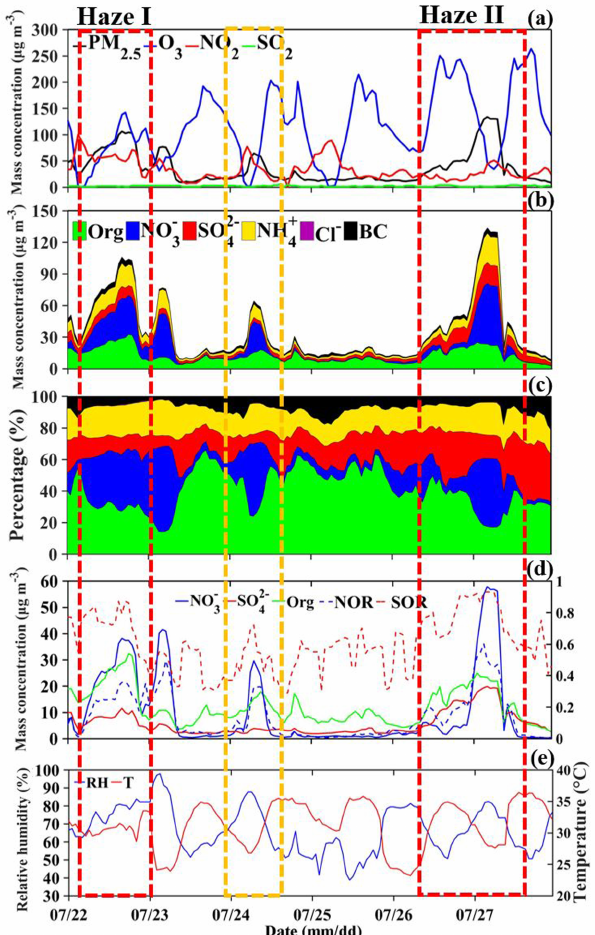
Figure 6. Temporal variation in the (a) PM 2 . 5 , O 3 , NO 2 and SO 2 mass concentrations; (b) PM 2 . 5 chemical composition, including organics (Org), sulfate (SO 2 − ), nitrate (NO − ), ammonium salt 4 3 (NH + ), chlorine salt (Cl − ) and black carbon (BC) at the BJ site 4 from 22 to 27 July 2019. (c) Temporal variation in the relative con- tributions of the chemical components to the PM 2 . 5 mass concentra- tion at the BJ site from 22 to 27 July 2019. (d) Temporal variation in the mass concentrations of the dominant PM 2 . 5 chemical com- ponents, sulfur oxidation ratio (SOR) and nitrogen oxidation ratio (NOR) at the BJ site from 22 to 27 July 2019. (e) Temporal varia- tion in the relative humidity (RH) and temperature ( T ) at the BJ site from 22 to 27 July 2019 (the yellow box represents the light-haze pollution period, and the red box represents the heavy-haze pollu- tion